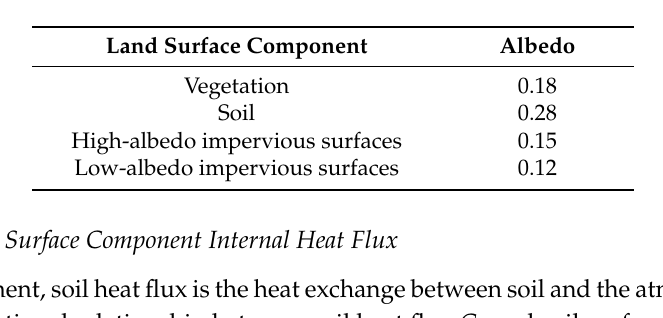
Table 6. Average albedo of the four components for the study